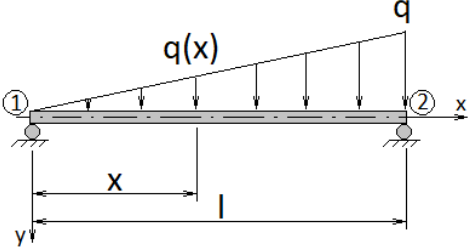
Figure 8. Simply supported bar and subjected to bending.